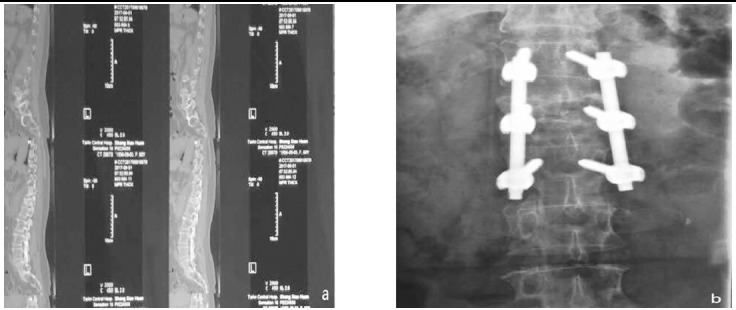
Female, aged 61 years old, a: T-12 vertebral compression fracture before surgery (IV degree); b: screw-rod internal fixation after surgery and vertebral body graft.